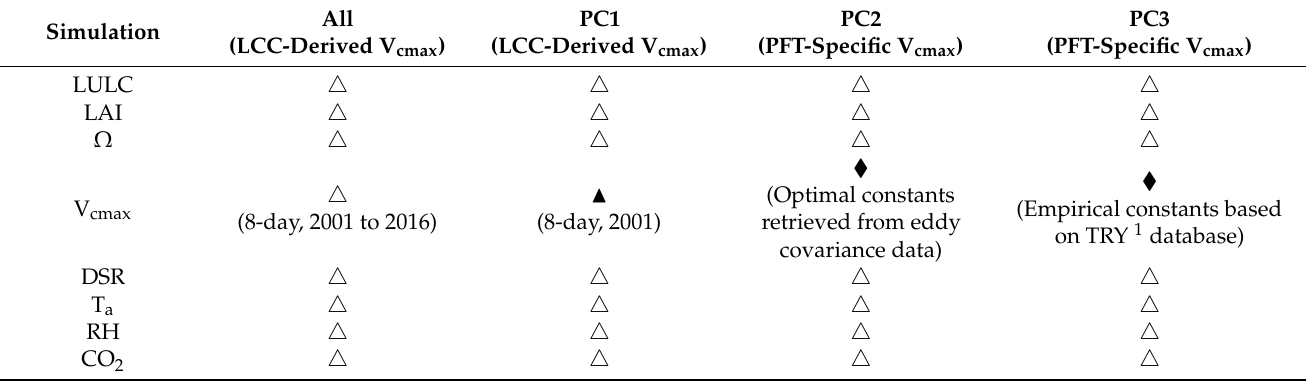
Table 2. Scenario designs used to quantify the effects of changes in photosynthesis capacity (PC) on GPP based on the FGM. The symbol ‘ (cid:52) ’ indicates that the input variable changes over time, while the symbol ‘ (cid:78) ’ indicates that the seasonality of V cmax on a large scale is included. The symbol ‘ (cid:7) ’ indicates that the input variable is fixed at a biome-specific